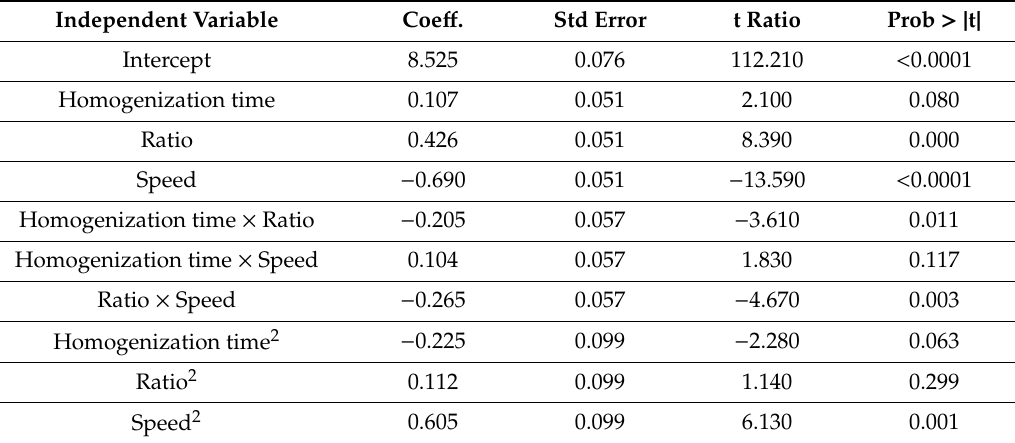
Table 3. Coe ffi cients of the standard regression model. Table 3. Coefficients of the standard regression model.